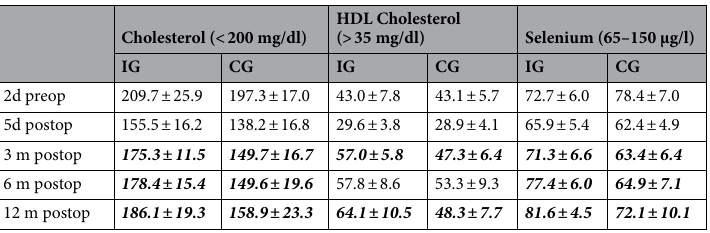
Table 2. Mean and 95% confidence interval for the three laboratory parameters showing significant differences in t-tests with regards to the influence of physiotherapy on the micronutritional status. Significant differences are marked by bold italics. IG: intensive group, CG: control group. Norm values are given in the brackets below the parameter name.